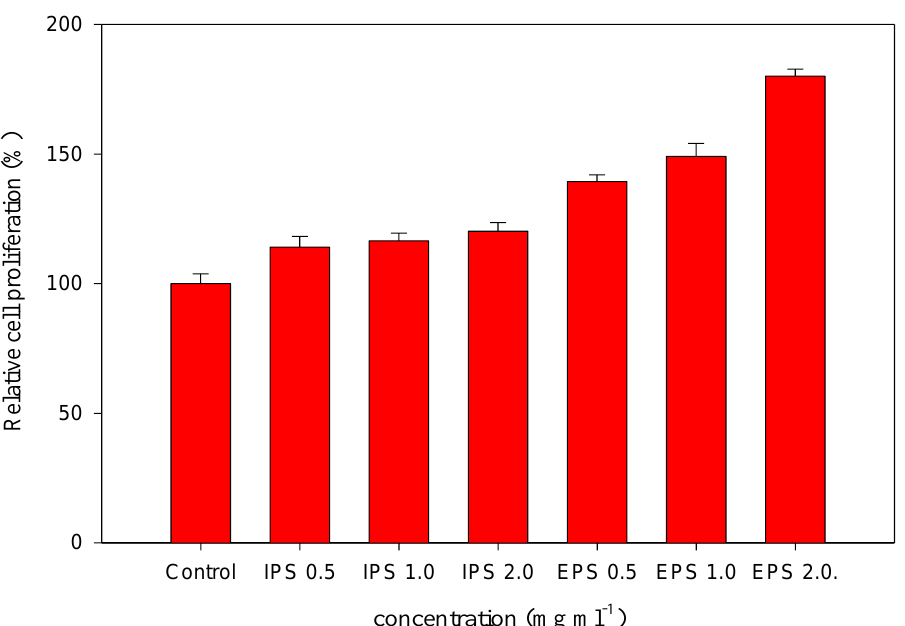
Figure 6. Cellular morphology of RINm5F cell grown in 96-well flat-bottomed plates.